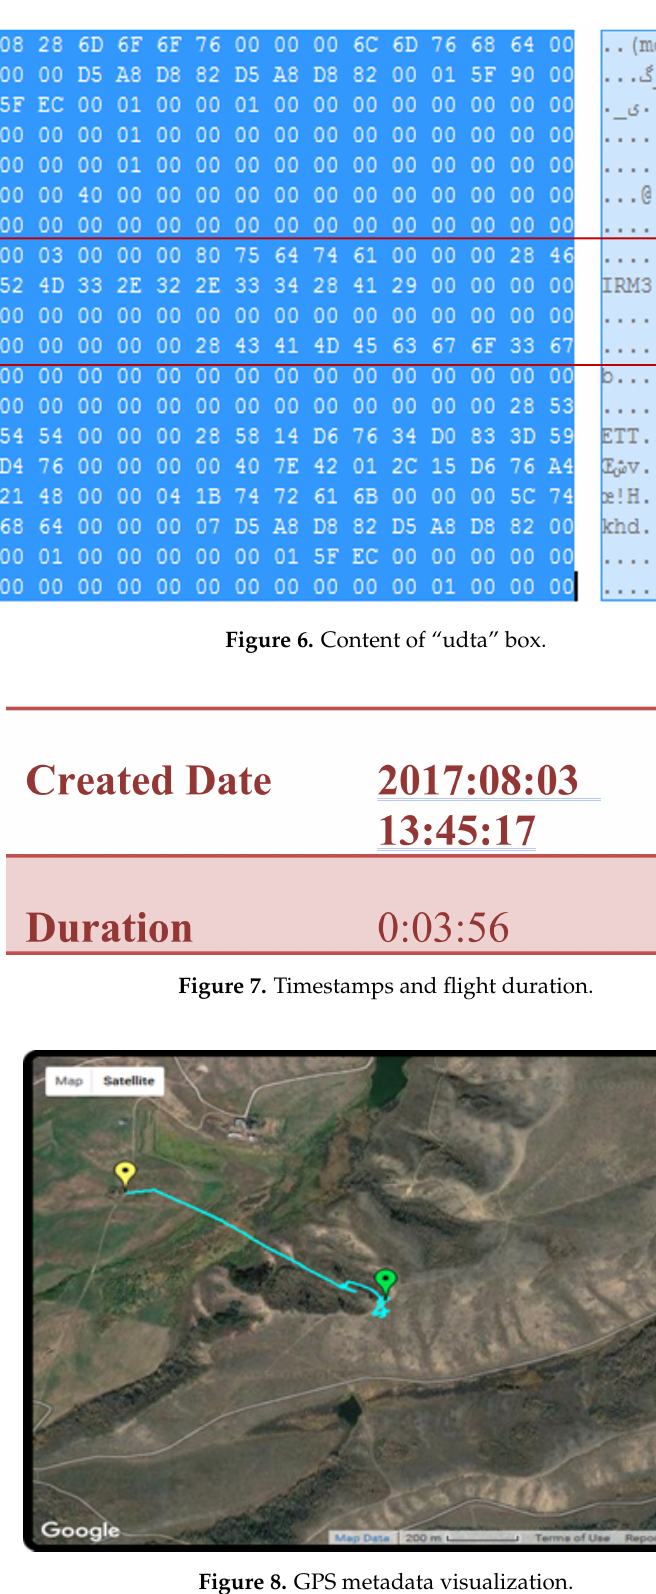
Figure 8. GPS metadata